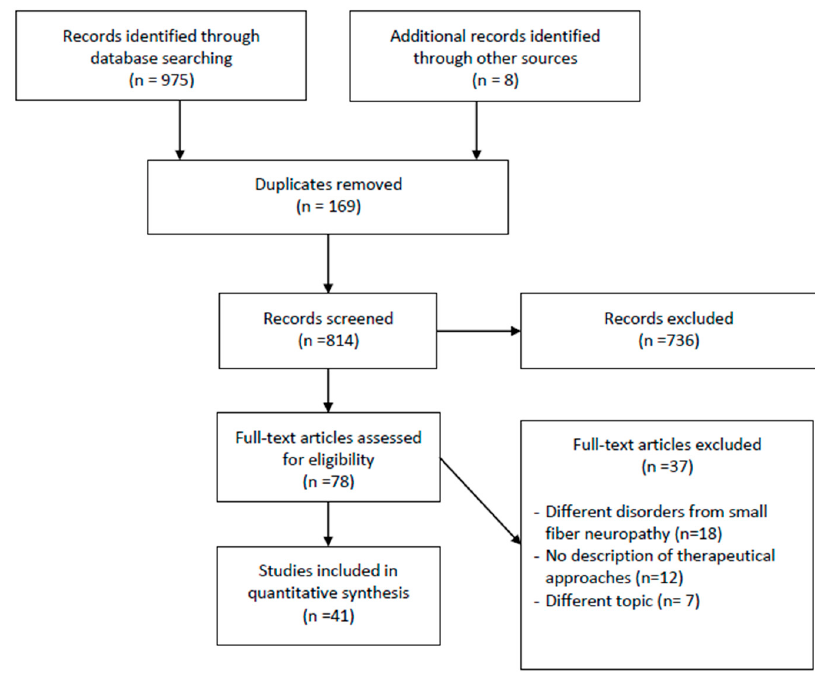
Figure1. Figure 1. Flowchart of the process of literature search and extraction of studies meeting the inclusion criteria.